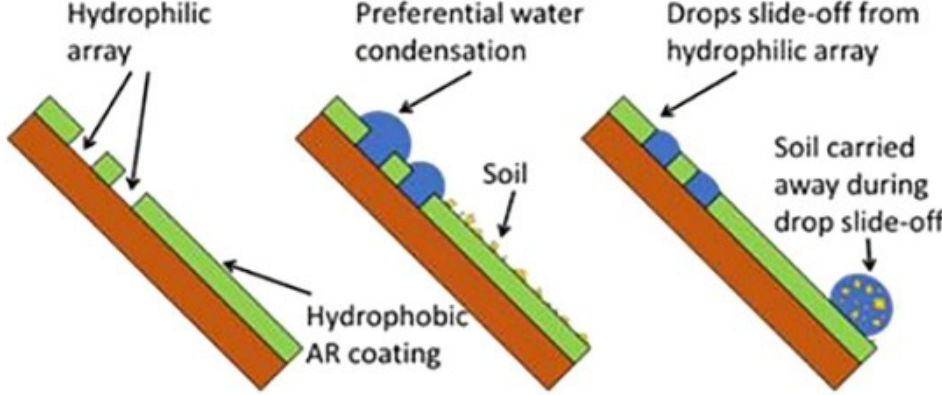
Figure 37. Hybrid hydrophobic–hydrophilic schematic diagram [153].